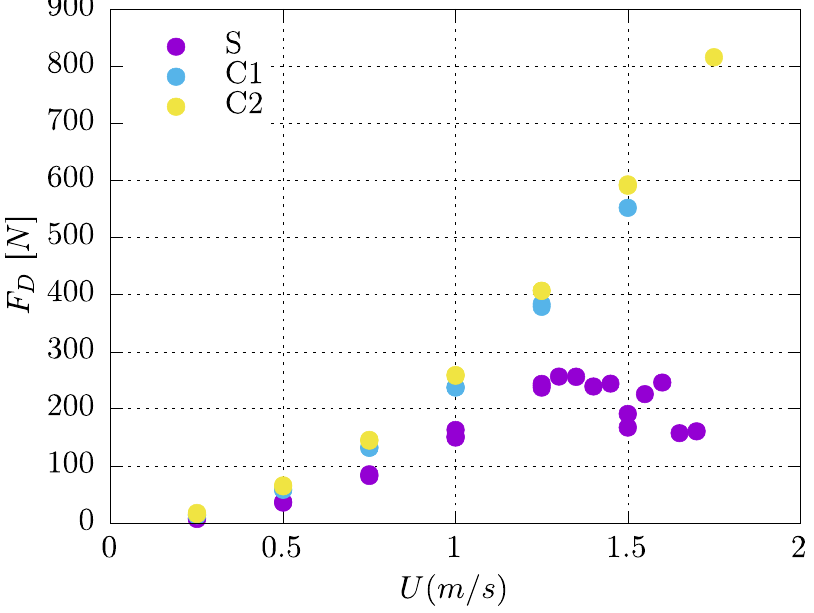
Figure 8. Drag force evolution for the three tested cases.